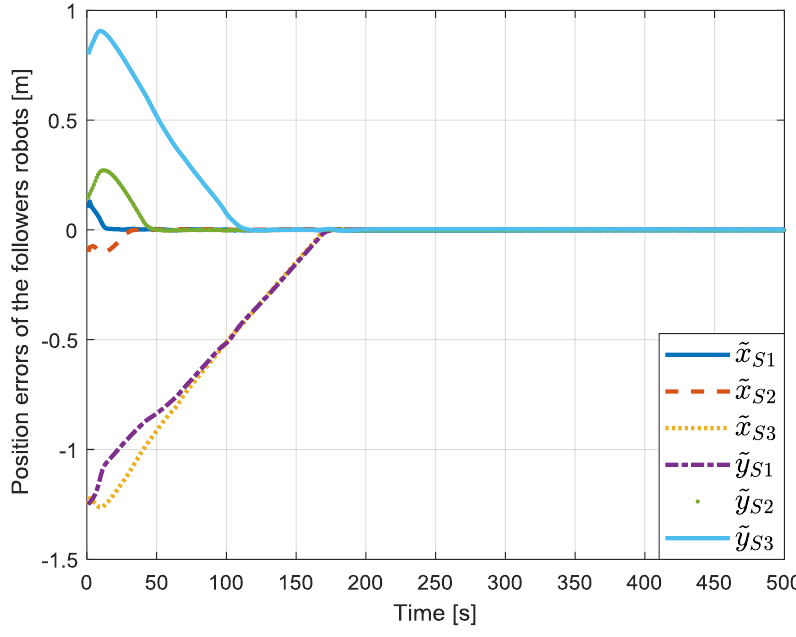
Figure 12. Position errors of the follower